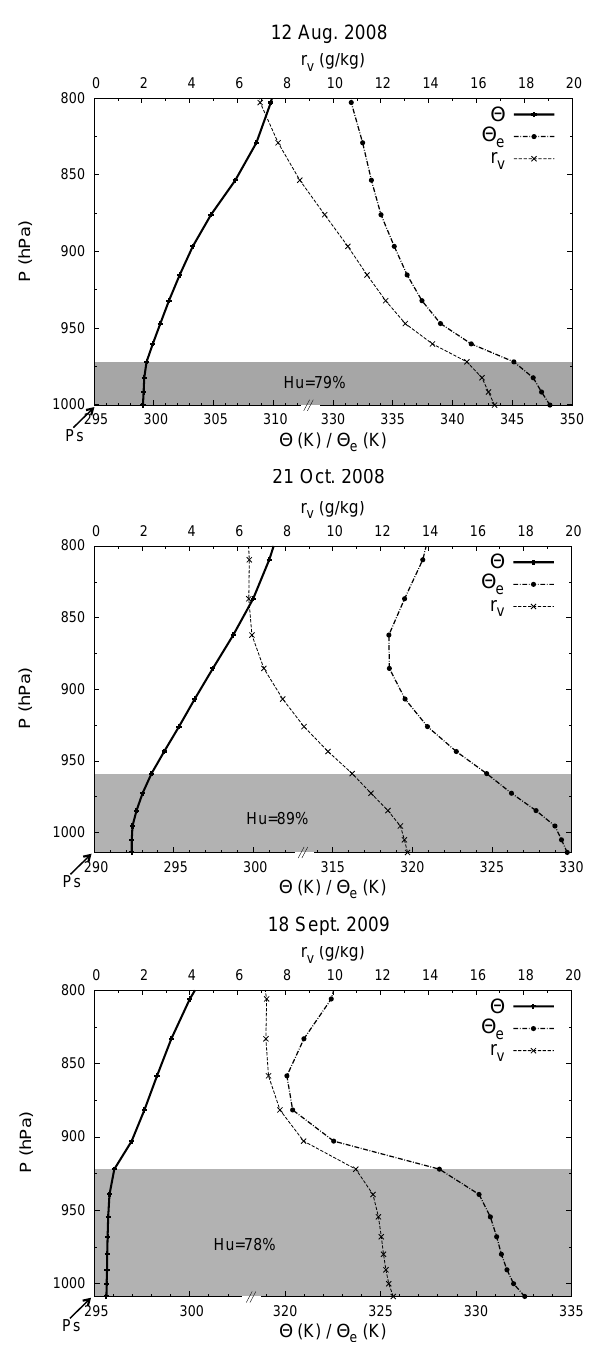
Fig. 10. Average potential temperature ( θ in K), equivalent potential temperature ( θ e in K) and water vapour mixing ratio (r v in g/kg) profiles computed over the dashed boxes plotted in Figures 7 and 9 for the three cases 12 Aug. 2008 (top), 21 Oct. 2008 (middle) and 18 Sept. 2009 (bottom). The grey area represents the vertical extent of the conditionally unstable layer potentially involved in deep convection (CAPE ≥ 100 J kg − 1 ). The mean relative humidity in this unstable layer is also given.